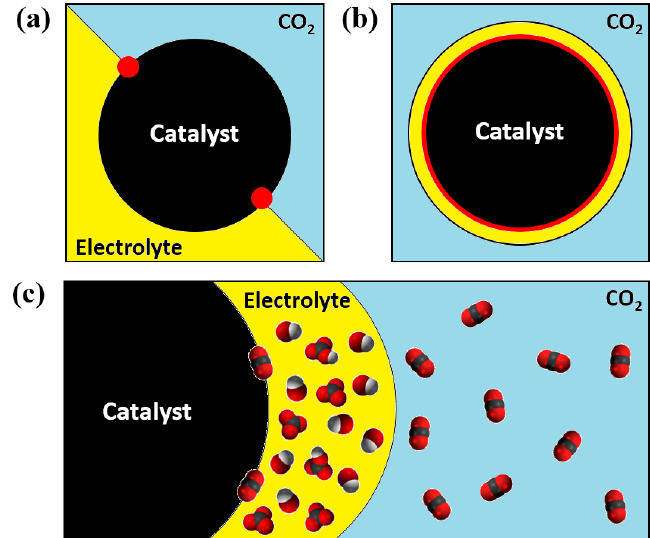
Figure 9. Illustration of the impact of phases and carbonation on CO 2 availability at a catalyst particle. ( a ) In the three-phase process, CO 2 conversion takes place only in the locus of reaction where CO 2 , electrolyte, and catalysts come into contact at the same time (full red circles). ( b ) In the two-phase process, the electrolyte wets the particle, forming a thin layer on the catalyst (yellow ring). In this case, the locus of CO 2 reduction is the entirety of the catalyst surface (red ring). ( c ) CO 2 and hydroxide ions generate bicarbonate and carbonate ions as CO 2 diffuses in a thin layer of alkaline electrolyte. Only a few CO 2 molecules are available for conversion on the catalyst surface.